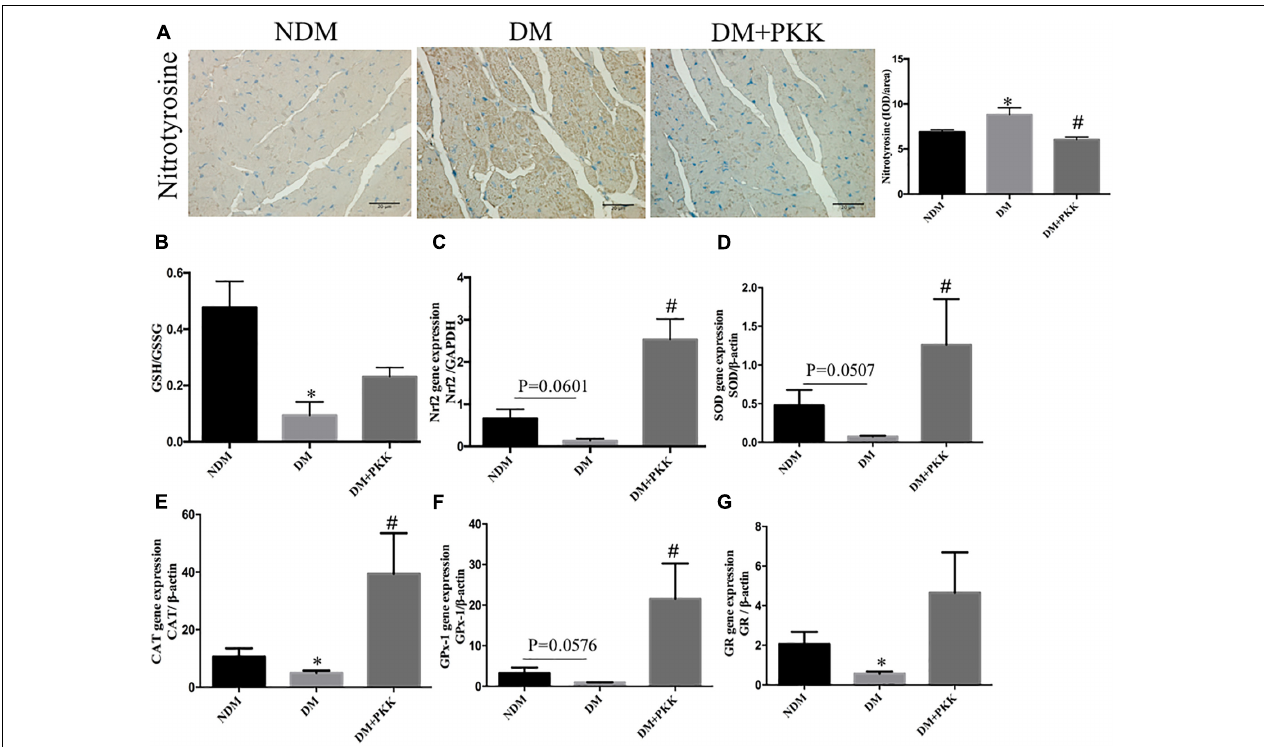
FIGURE 2 | Pancreatic kallikrein administration protected against myocardial oxidative stress in STZ-induced diabetic rats. (A) Representative IHC micrographs of myocardium tissues stained with nitrotyrosine for the NDM, DM, and DM + PKK groups (original magnification × 40). The IHC scores of myocardium sections were quantified. (B) Myocardial GSH/GSSG ratio. (C–G) The mRNA expression of markers related with oxidative stress in heart tissues. (C) Nrf2, (D) SOD, (E) CAT, (F) GPx-1, and (G) GR. Each sample for qPCR was repeated for three times. Values are mean ± SEM, n = 6 per group; ∗ P < 0.05 vs. NDM group; # P < 0.05 vs. DM + PKK